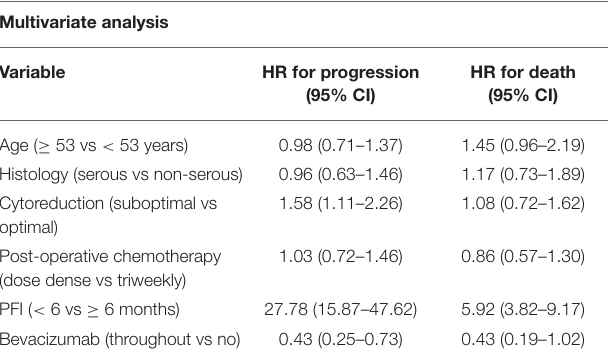
TABLE 4 | Multivariate analysis in newly diagnosed cancer patients with stage III and IV disease ( n = 234). Multivariate